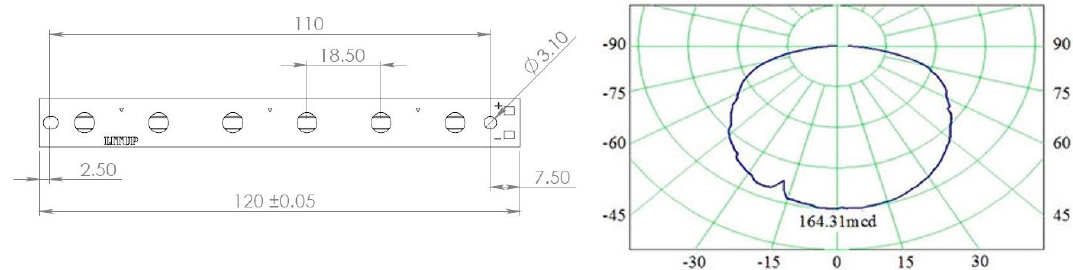
Figure 6. Ultraviolet (UV) LED light source used in the proposed system and its spatial light-intensity distribution curve.